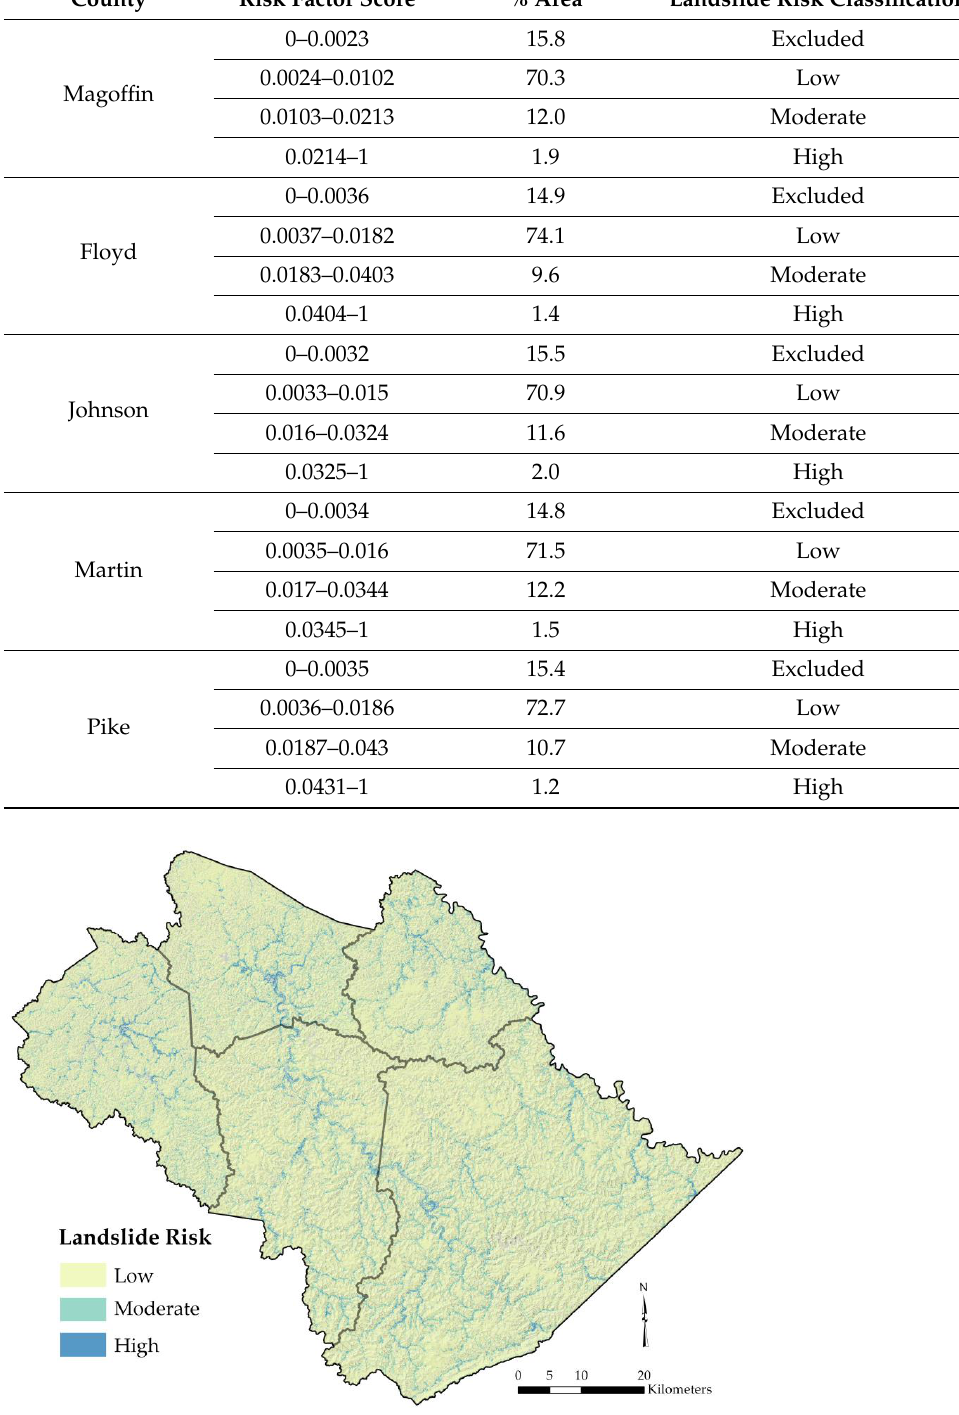
Figure 10. Landslide risk for the Big Sandy Area Development District. County boundaries are Fig 10 shown in